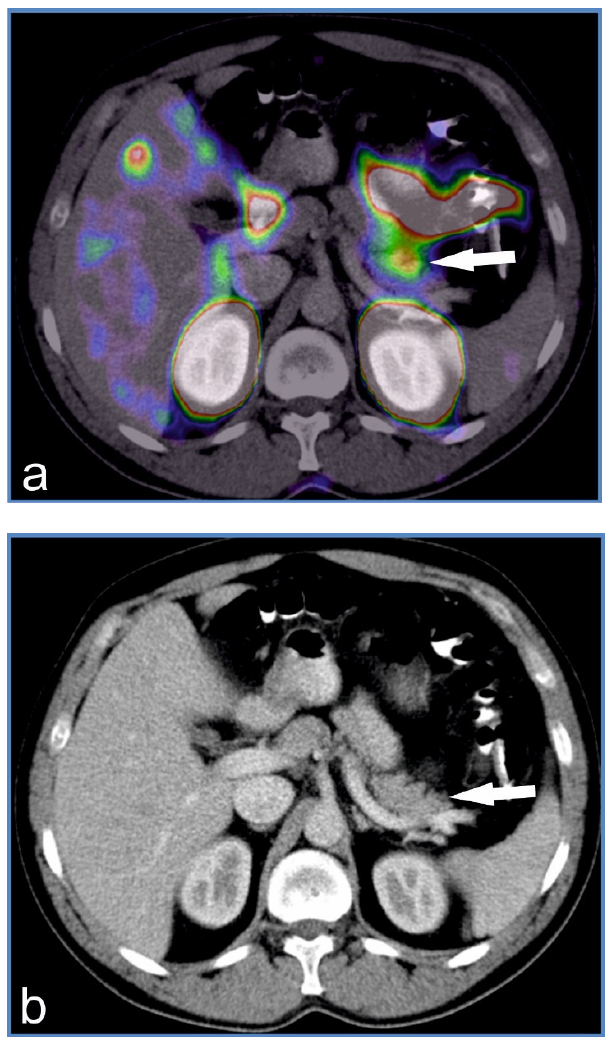
Figure 4. Diffused uptake of tracer found in the body/tail of the pancreas observed via 99mTc-GLP- 1 scintigraphy ( a ) and transverse abdominal computed tomography imaging of the pancreas ( b ) in patient I.1 [21].